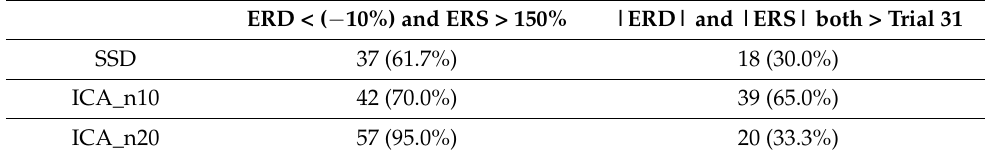
Table 1. Number of trials (out of 60 total) that meet each